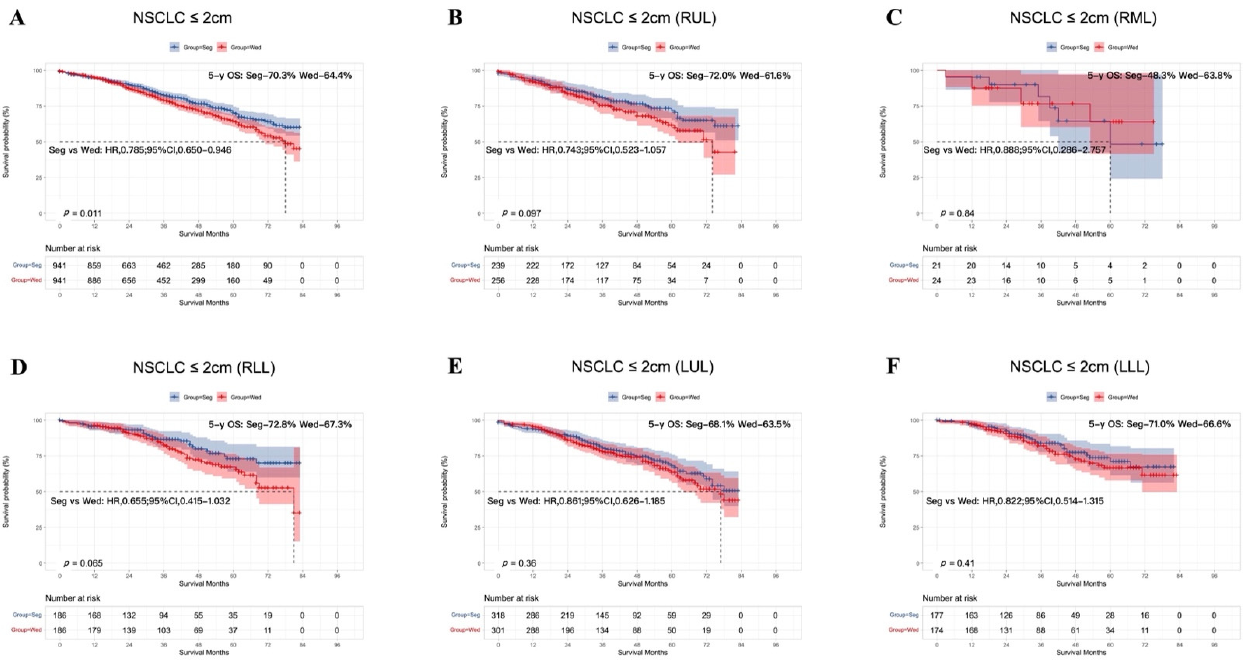
Figure 2. Kaplan–Meier survival curves after segmentectomy or wedge resection in NSCLC patients with tumors ≤ 2 cm after PSM ( A ). Survival curves for the RUL ( B ), RML ( C ), RLL ( D ), LUL ( E ), and LLL ( F ) after PSM.